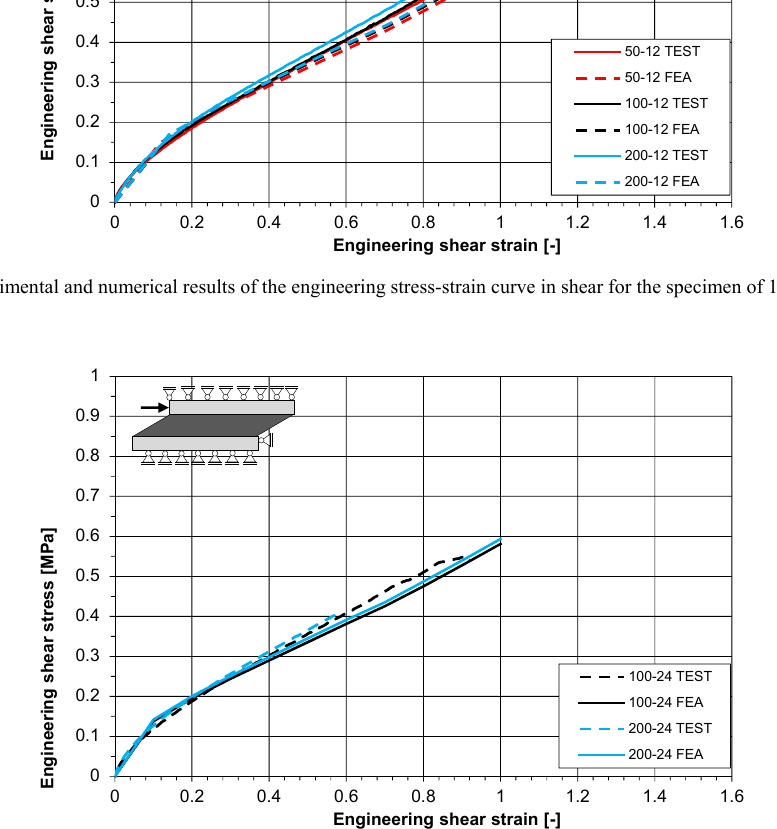
Fig. 22 Experimental and numerical results of the engineering stress-strain curve in shear for the specimen of 24 mm